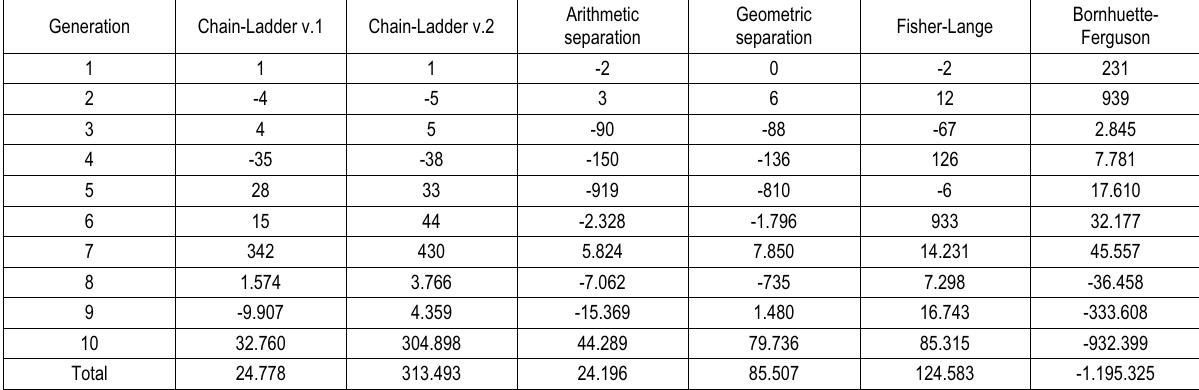
Table 2. Bias method of random development factors